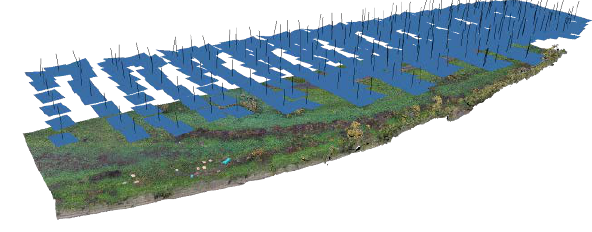
Figure 4. Flight structure. 232 images taken at 100m height Aerial photography of the ship using a UAV at low altitude was additionally performed to increase accuracy of geometry of the 3D model constructed using terrestrial photogrammetry.